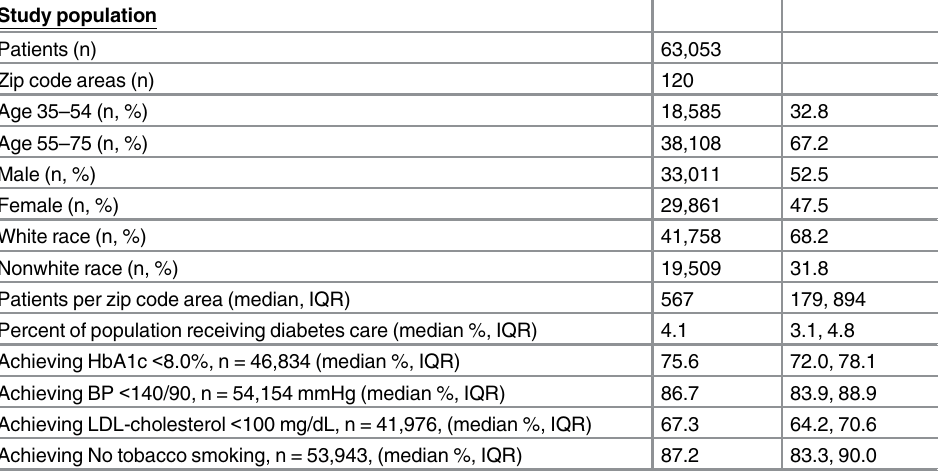
Table 1. Descriptive Statistics of the Patient Population and Zip Code Areas of